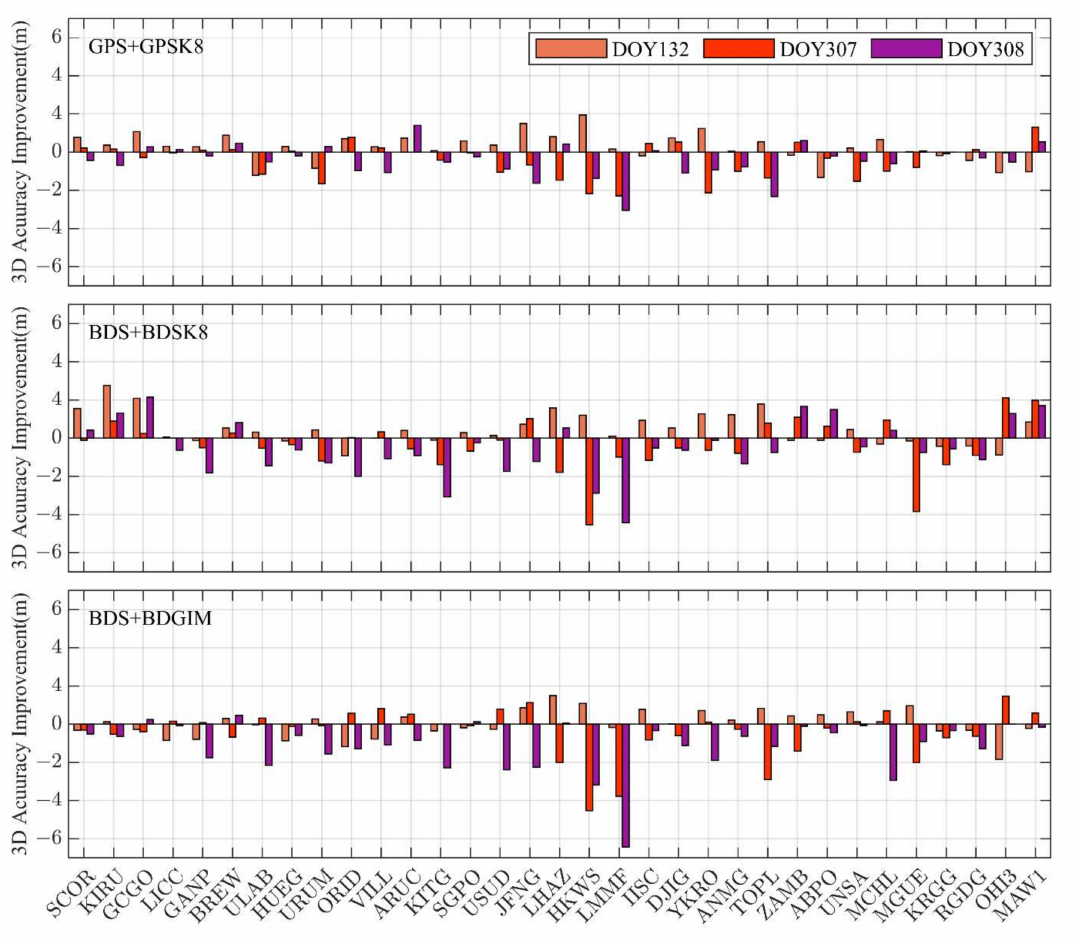
Figure 7. Improvement in 3D positioning accuracy for all stations during strong geomagnetic storms compared to reference periods for GPS + GPSK8, BDS + BDSK8, and BDS + BDGIM. When the value is negative it means a decrease in